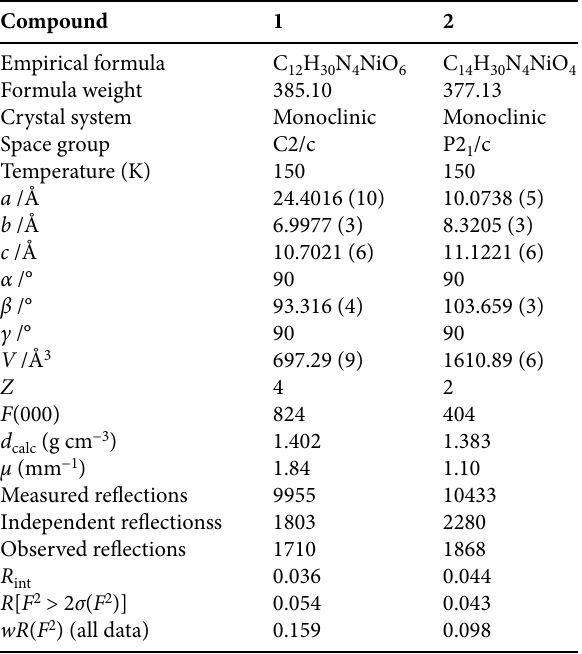
Table 1 . Crystallographic data and structural refinement for com- plexes 1 and 2